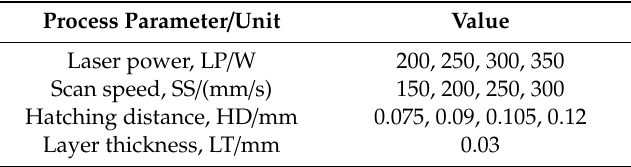
Table 1. Process parameters used in this work.